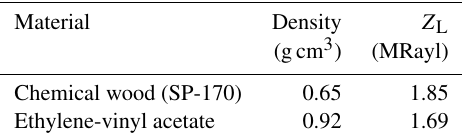
Table 2. Specifications of matching layers.